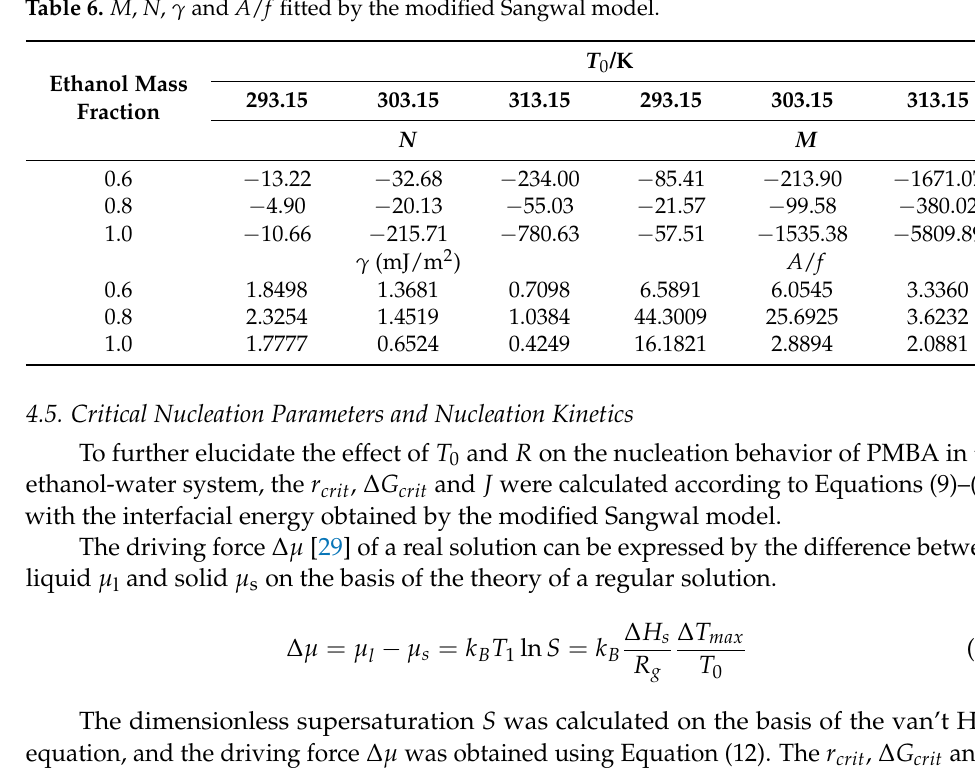
Table 6. M , N , γ and A / f fitted by the modified Sangwal model.